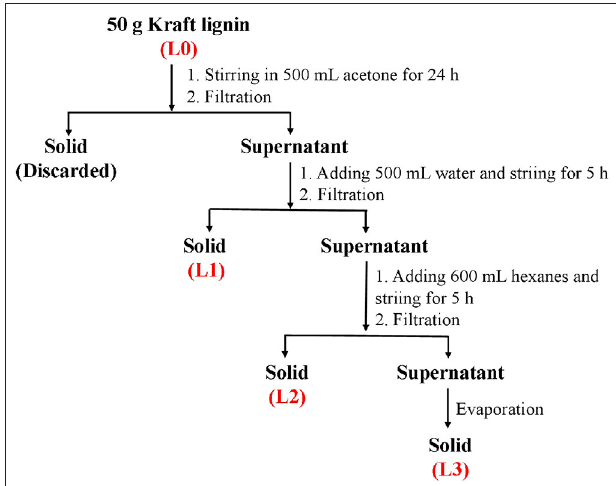
SCHEME 1 | The process for fractionation of bamboo kraft